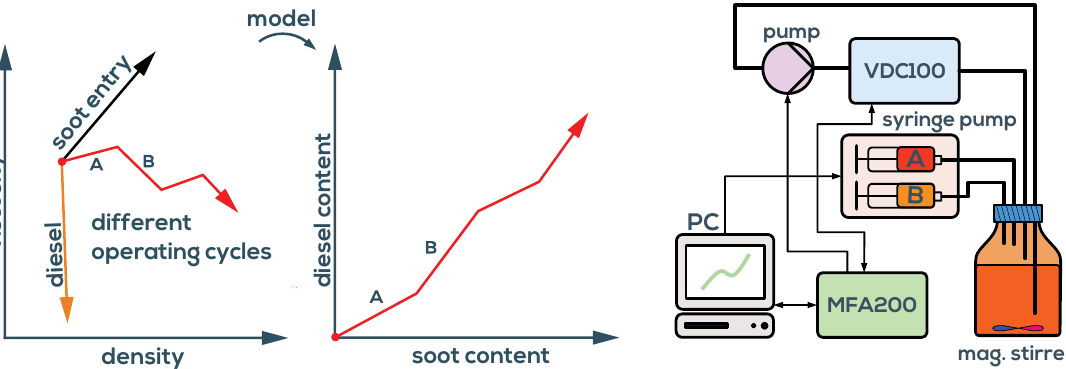
Figure 10. Left : diesel and soot entry influence viscosity and density differently and can therefore be calculated using a fluid model. Various operating conditions at the engine test stand can therefore be evaluated online. Right : Schematic of the laboratory test setup for concept evaluation.